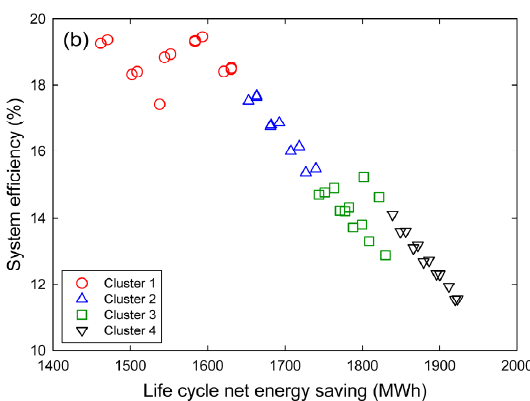
Figure 8. Correlation between LCES and energy performance of non ‐ dominated solutions for last generation: ( a ) solar fraction vs. LCES and ( b ) system efficiency vs. LCES.